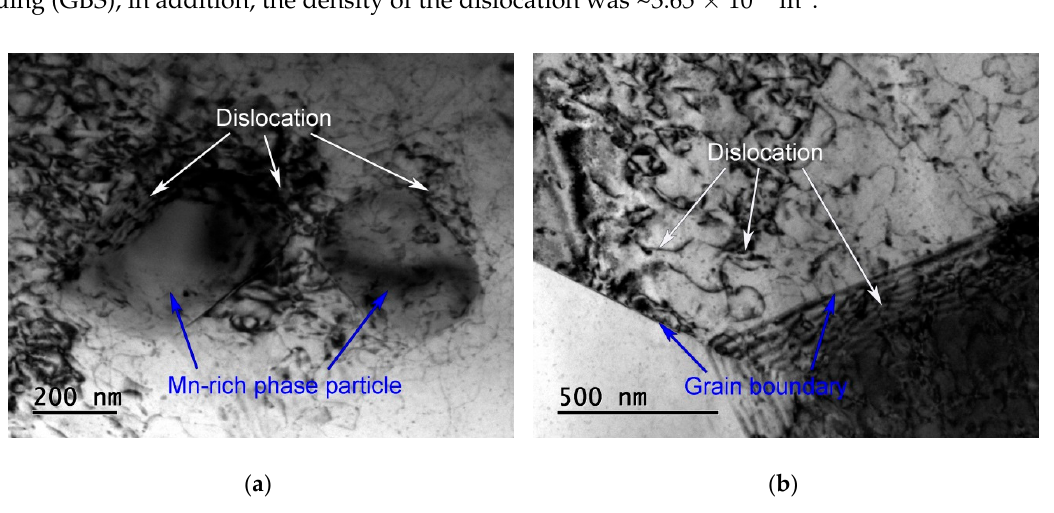
Figure 2. The relationship between the dislocations, precipitate phases ( a ) and grain boundaries ( b ) found using the TEM tests at 500 °C and 1 × 10 − 3 s − 1 ( ε =